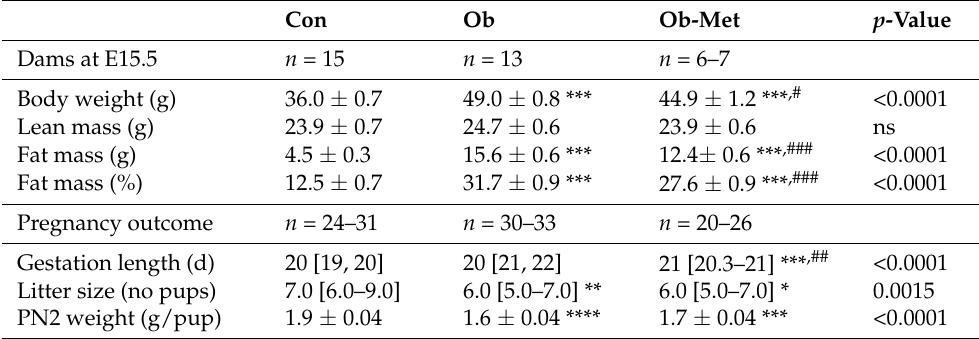
Table 1. Dam body composition and pregnancy outcomes. * p < 0.05, ** p < 0.01, *** p <